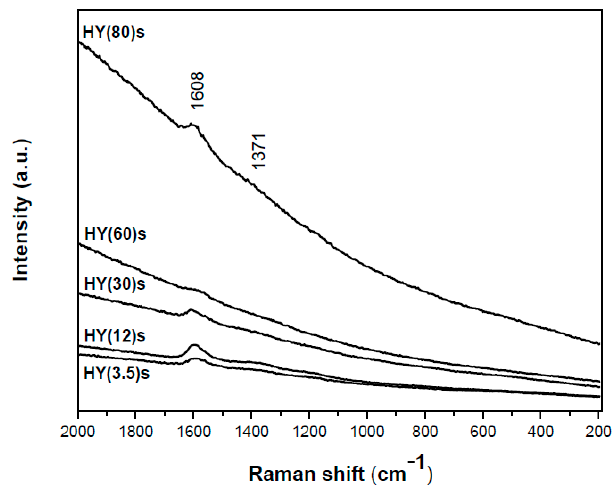
Figure 12. Raman spectra of the spent zeolites.